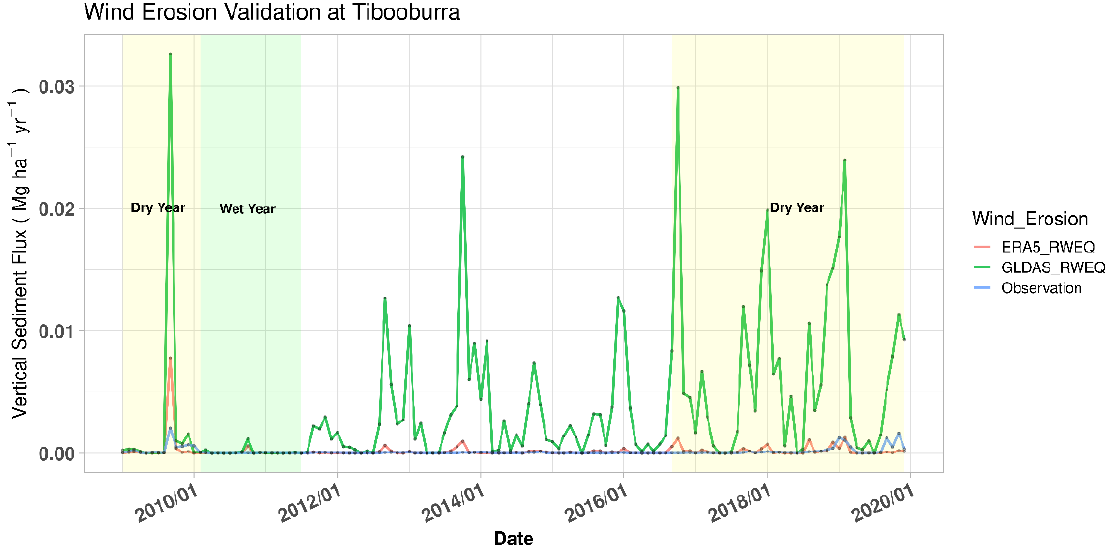
Figure 3. Monthly wind erosion values from the ERA5_RWEQ model, the GLDAS_RWEQ model, and the observations at the Tibooburra site compared for the period 2009 to 2019.